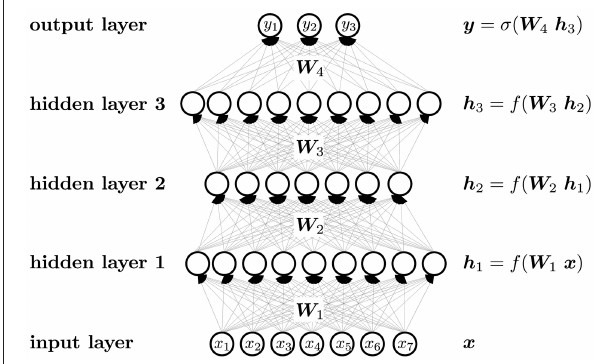
FIGURE 5 | Schematic representation of a